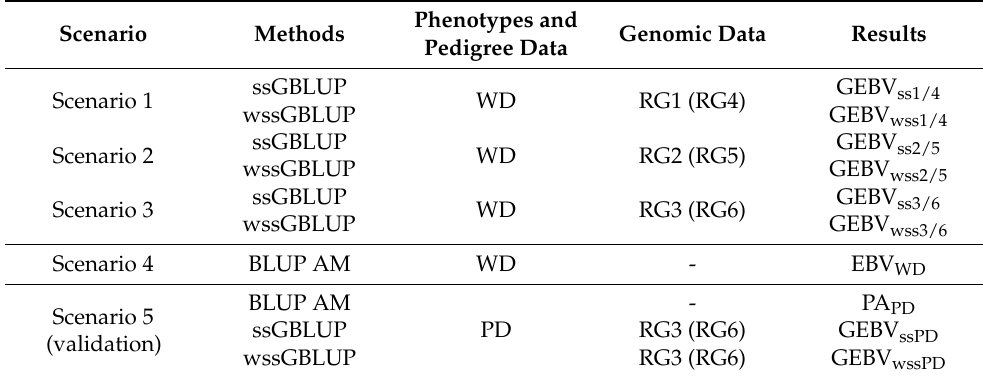
Table 2. Calculation